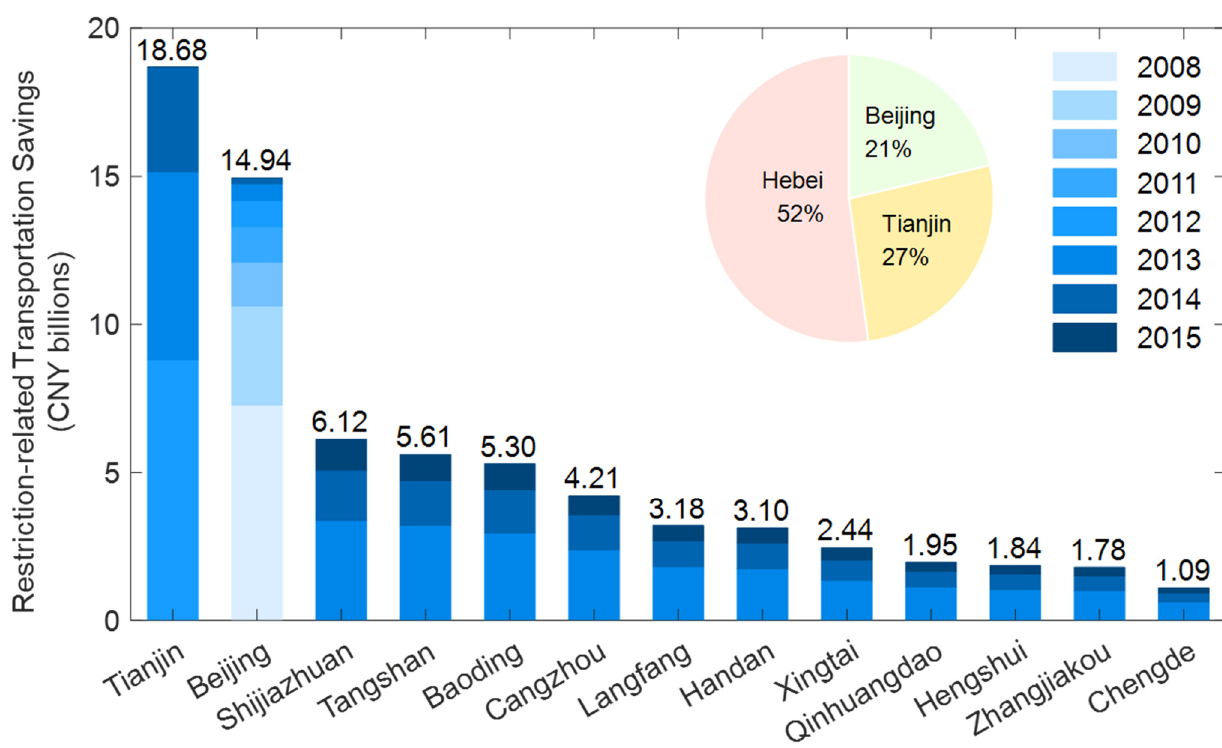
Figure 4. Restriction-related transportation savings from HEV driving area restriction policy.